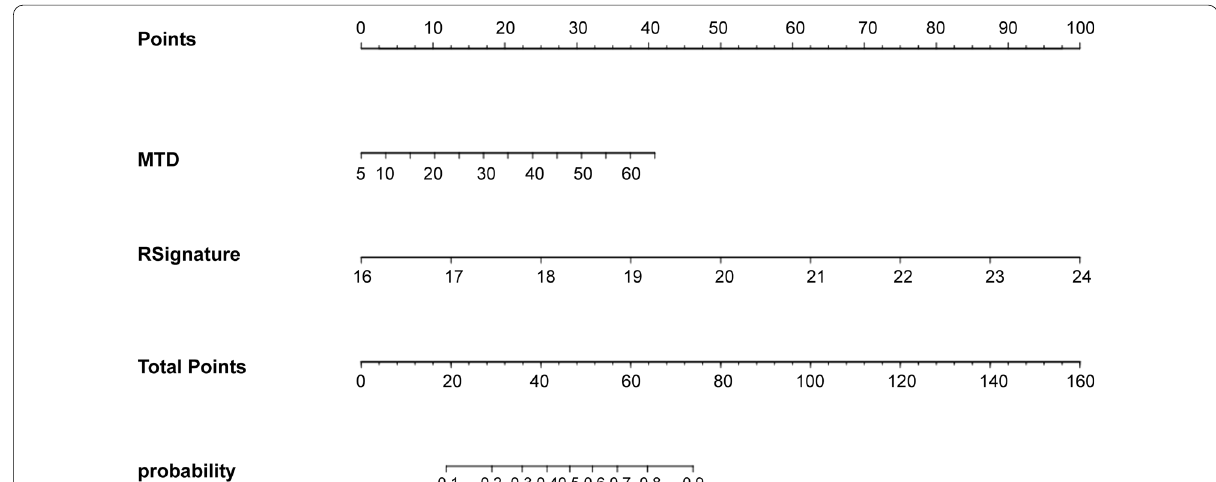
Fig. 4 Nomogram for individual prediction of the probability of middle or deep stroma invasion in early stage CC. The nomogram was was a visual representation of the combined model in training cohort, which integrated radiomics signature and independent risk factor. The radiomics signature in the nomogram was the linear sum of the selected 5 radiomics features and their corresponding coefficients. (Rsignature: radiomics signature; MTD: maximal tumor diameter on MRI)